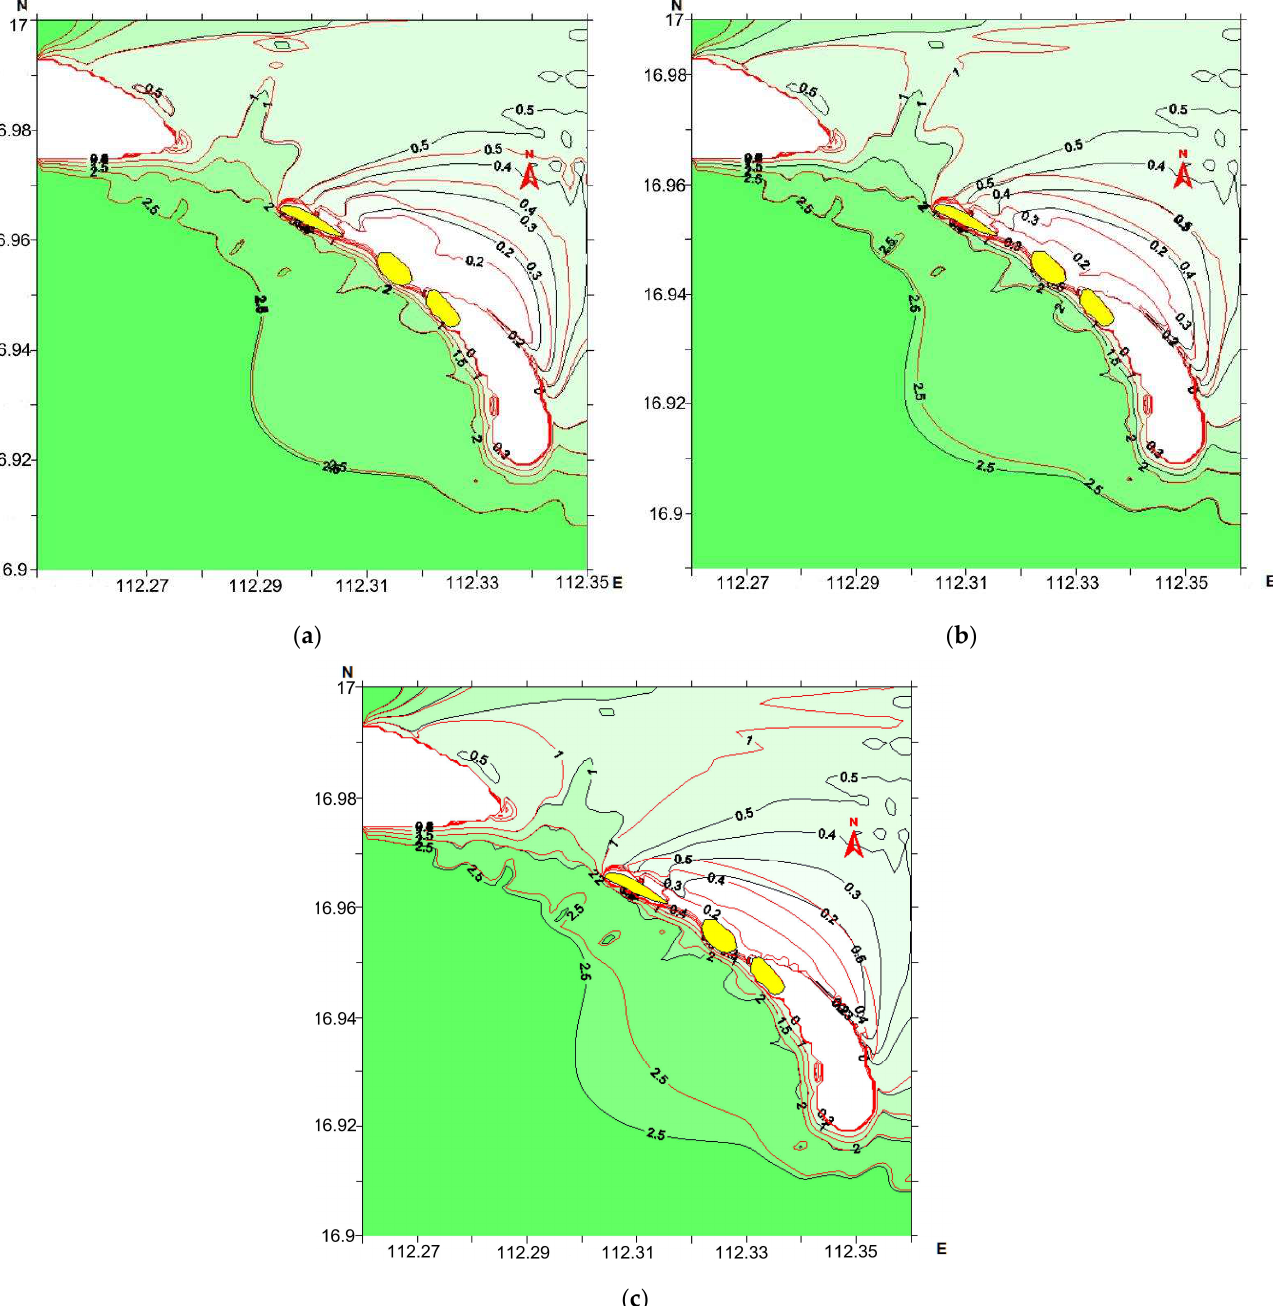
Figure 8. Effects of wind grade 3( a ), 4( b ) and 5( c ) on wave fields around the islands, reefs and newborn sandbank. (The black lines in the figure are windless, and the red lines are windy).